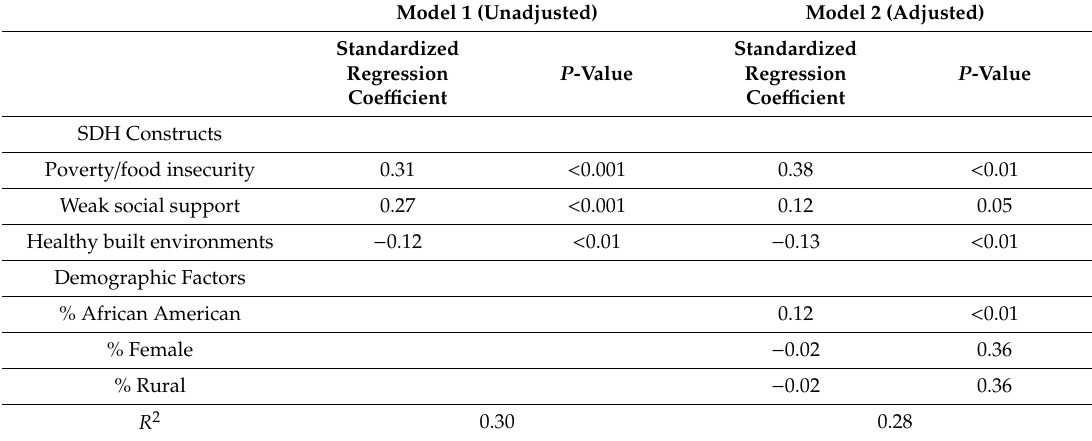
Table 2. Associations between antihypertensive medication non-adherence and social determinants of